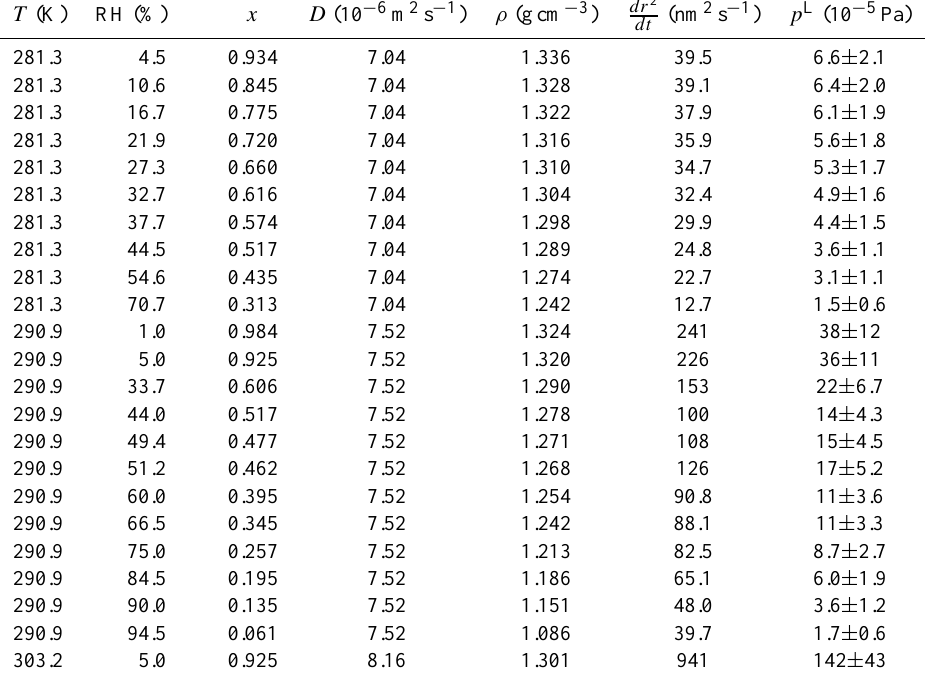
Table 2. Raw data of the glutaric acid experiments: temperature, RH, glutaric acid mole fraction, x , as calculated from measured RH using UNIFAC-Peng, glutaric acid gas phase diffusion coefficient, D , solution density, ρ , and evaporation rate, needed to calculate the vapor pressure of the acid, p L , see Eq. (1). The pressure of the buffer gas (N 2 ) was kept constant at 800hPa in all